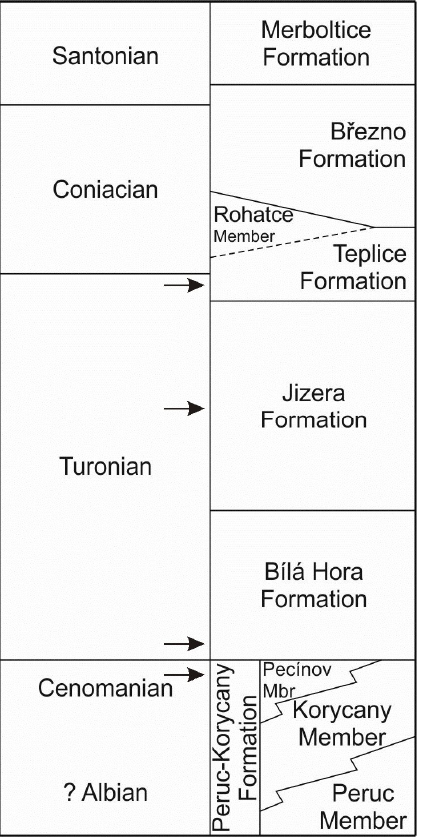
Figure 2. Stratigraphic sequence of the Bohemian Cretaceous Basin (Adopted from Reference [22] after References [19,20]. Arrows added to mark phosphate occurrences in the sequence.